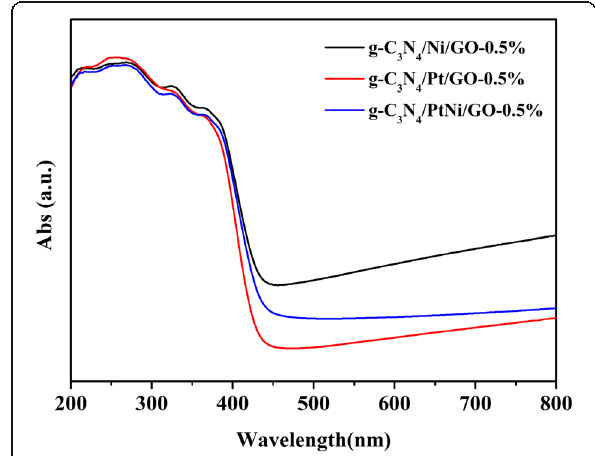
Fig. 7 UV-Vis diffuse reflectance spectra of g-C 3 N 4 /Ni/GO-0.5%, g-C